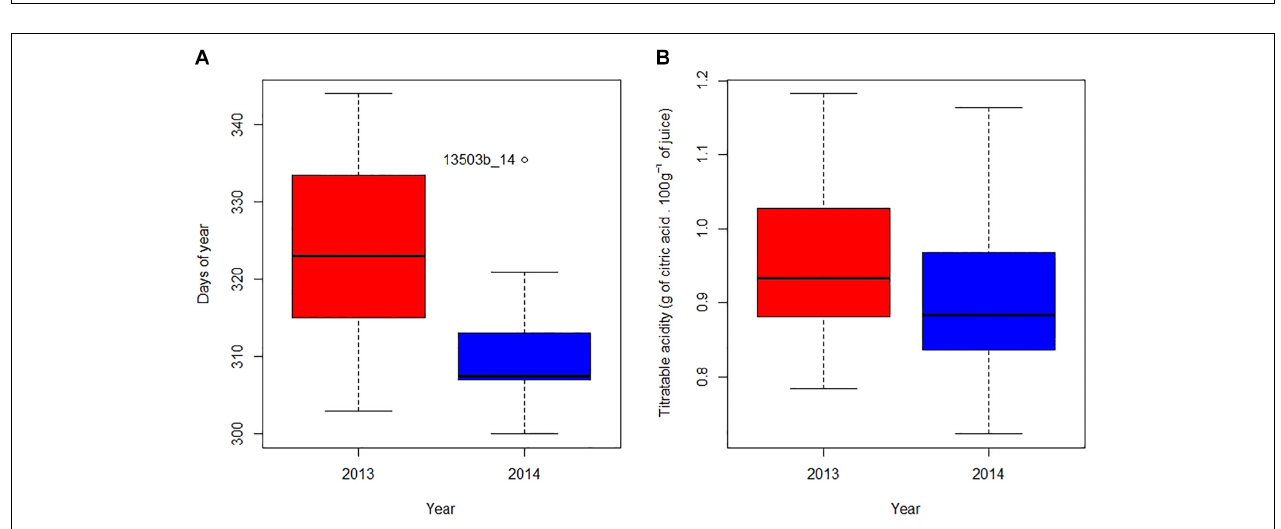
FIGURE 2 | Acidity asymptotic model and plots acidity in 2013 and 2014. Data are centered over time at t 0 = 1.4 g of citric acid/100g of juice.